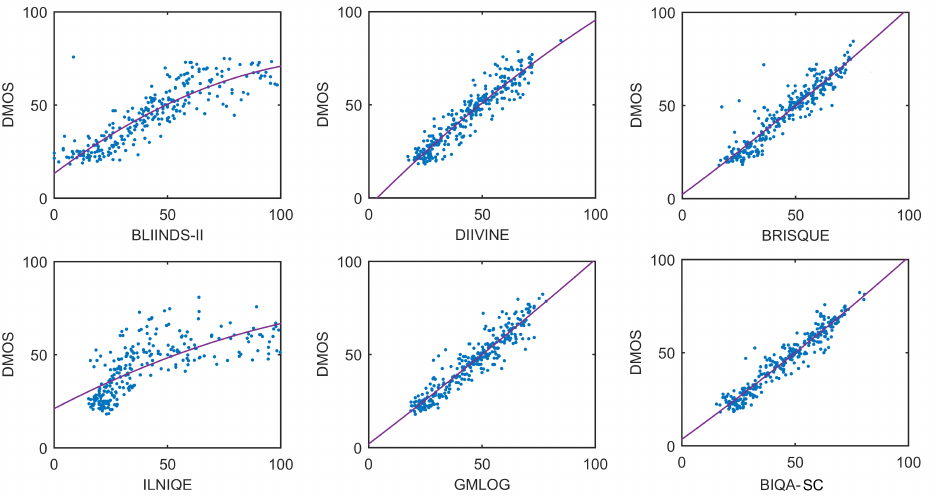
Figure 7. Box plots of SROCC and PLCC distributions of BLIINDS-II [13] (BL), DIIVINE [12] (DI), BRISQUE [15] (BR), GMLOG [19] (GM), BIQA-SC-I (SC-I), BIQA-SC-II (SC-II), and BIQA-SC (SC) across 1000 train-test trials on LIVE database [28]: ( a ) box plot of SROCC distributions; and ( b ) box plot of PLCC distributions.